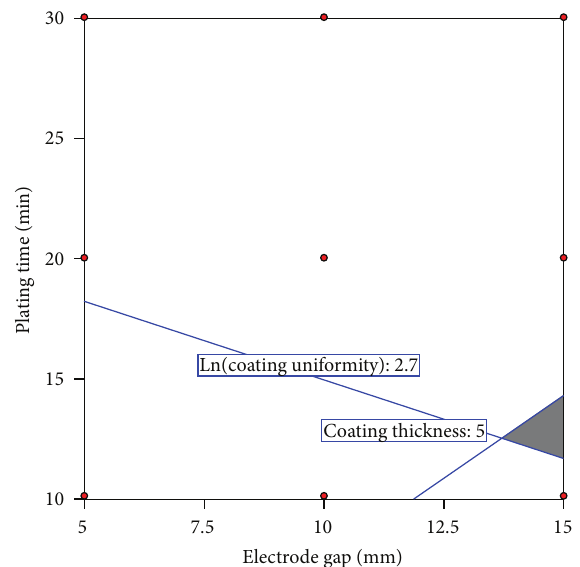
Figure 7: Overlay plot of the input variables for the predetermined output criteria of maximum of 5 𝜇 m coating thickness and mini- mum of 15% coating uniformity. (The grey area is the optimized